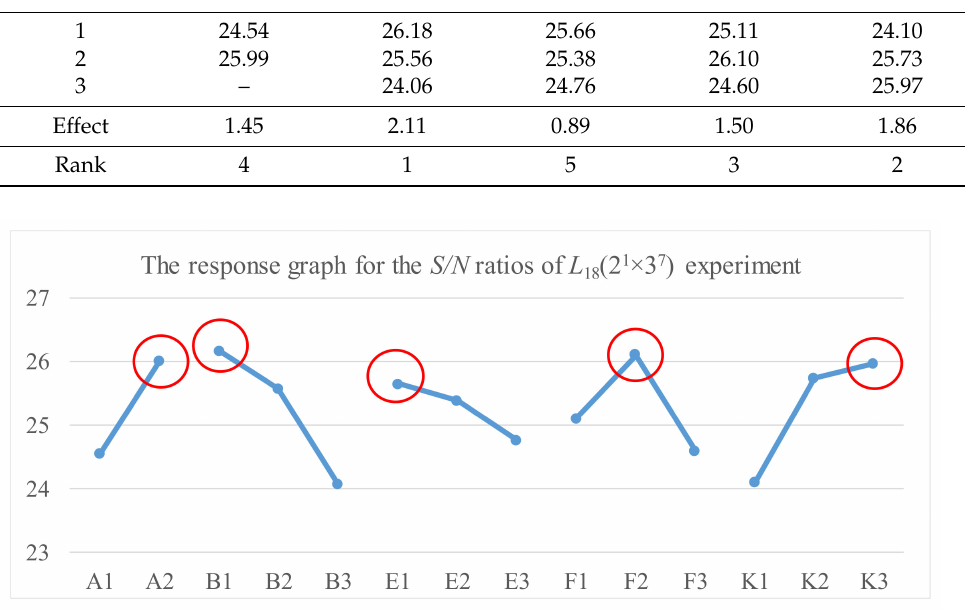
Figure 13. The response graph for the S/N ratios of the L 18 (2 1 × 3 7 )